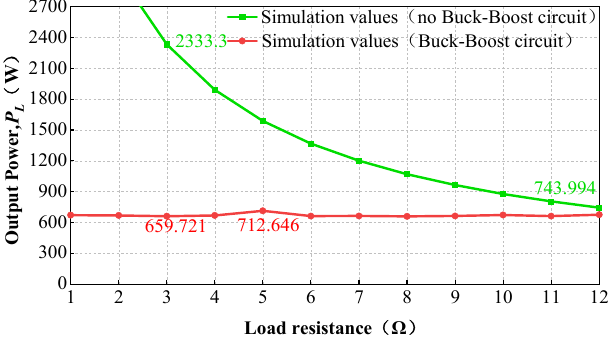
Figure 18. Output power curve under different resistance loads.